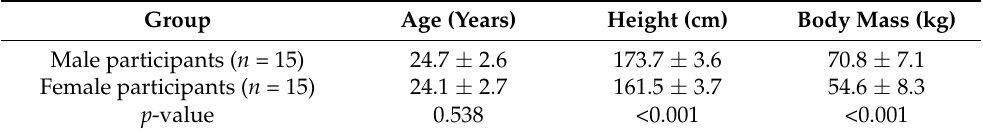
Table 1. Participant characteristics (mean ± SD).